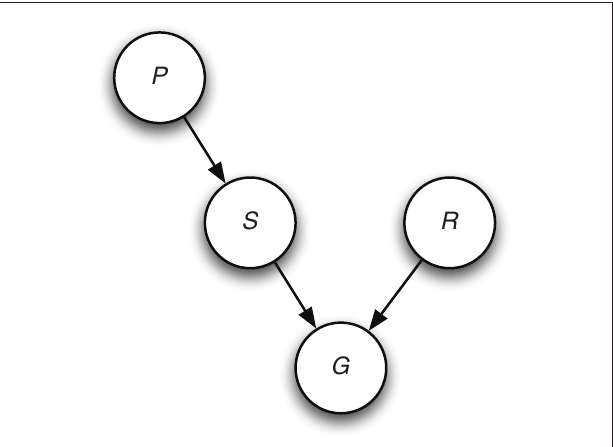
Figure A1 | A Bayesian network denoting static knowledge. This BN contains four variables: P , S , R , and G . These variables are dependent on each other as denoted by the arcs: S depends on P , G depends on S and R .